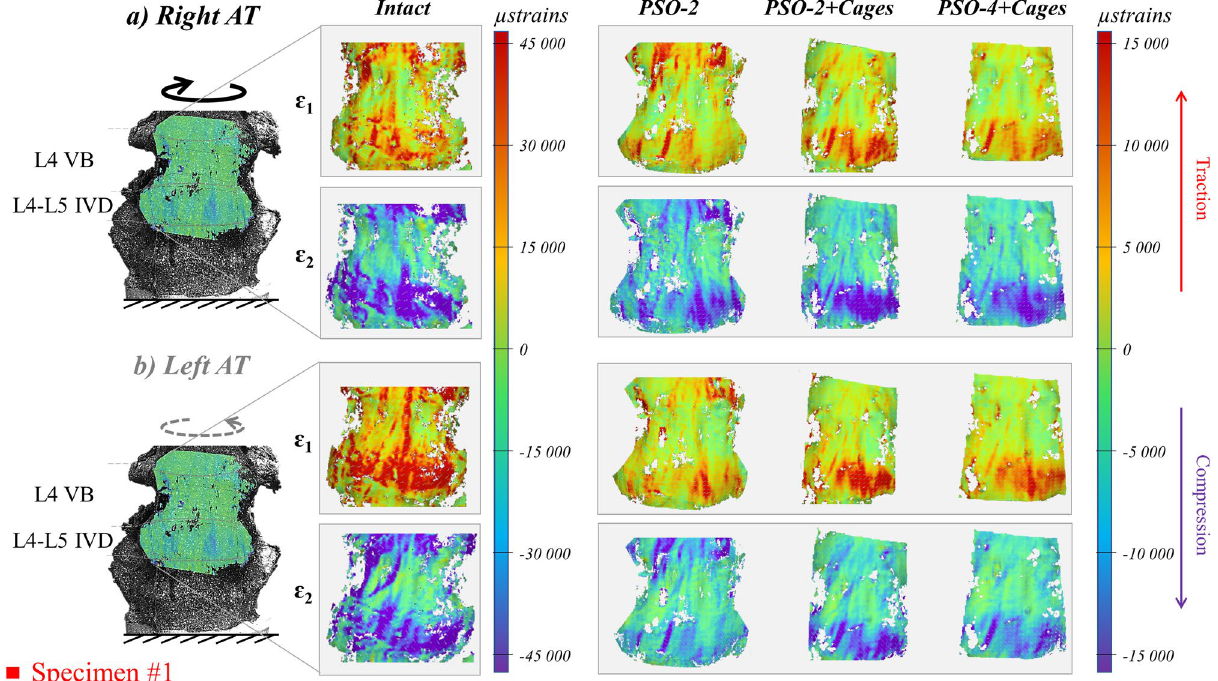
Figure 7. Axial torsion (AT) right ( a ) and left ( b ): tensile (ε 1 ) and compressive (ε 2 ) strain maps measured on the “Intact” condition and following PSO at L4 and posterior instrumentation with 2 primary-rods (“PSO-2”), with 2 rods and supplementary intervertebral cages (“PSO-2 + Cages”), and with supplementary accessory rods and intervertebral cages (“PSO-4 + Cages”). A picture of the specimen with the correlated areas is reported on the left, indicating the treated level (L4) and the caudal IVD. A representative specimen (#1) is shown here (strain maps for every specimen provided as Supplementary Figures). The DIC strain maps have been obtained